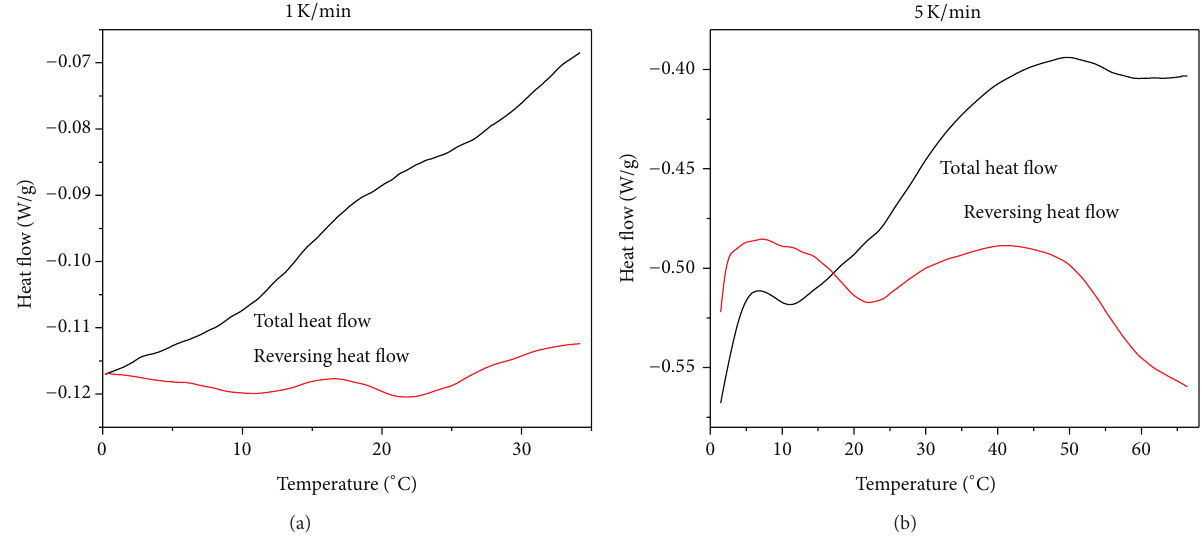
Figure 3: TM-DSC thermograms of PNIPA-SA/water (40%/60%) system in equilibrium swelling degree, upon heating rate of (a) 1K/min and (b) 5 K/min and cooling rate of 10